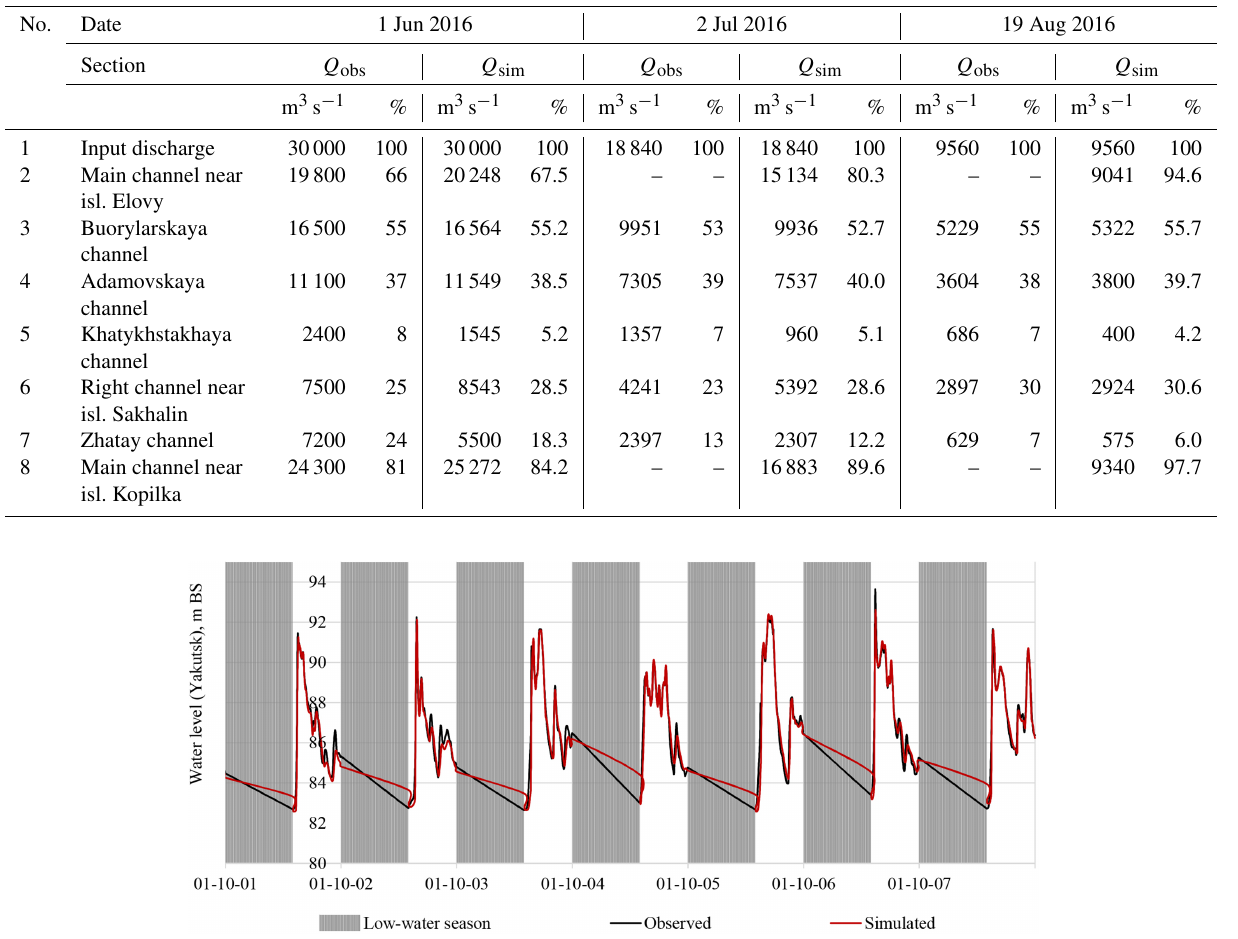
Table 1. Flow distribution according observation and modeling. No.